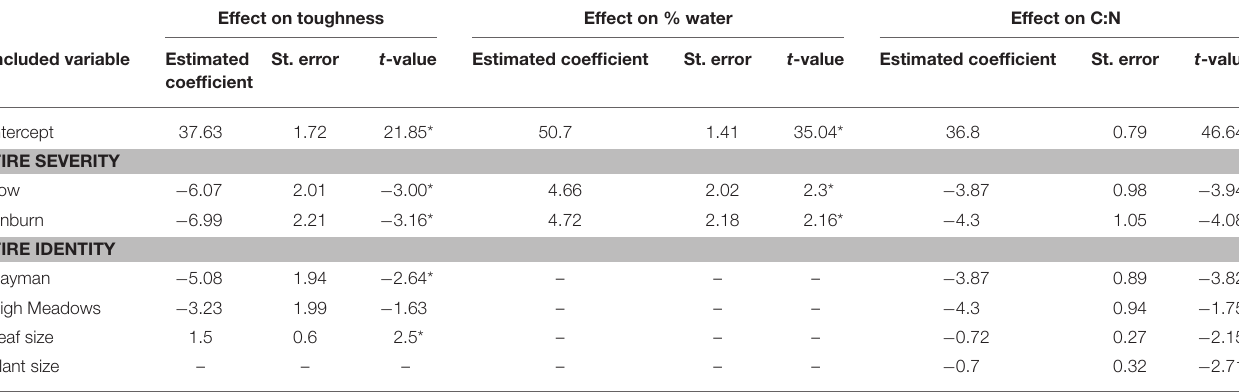
TABLE 2 | Model summary for the effect of each explanatory variable on three measures of host plant quality: leaf toughness, water content, and C:N ratio. Effect on toughness